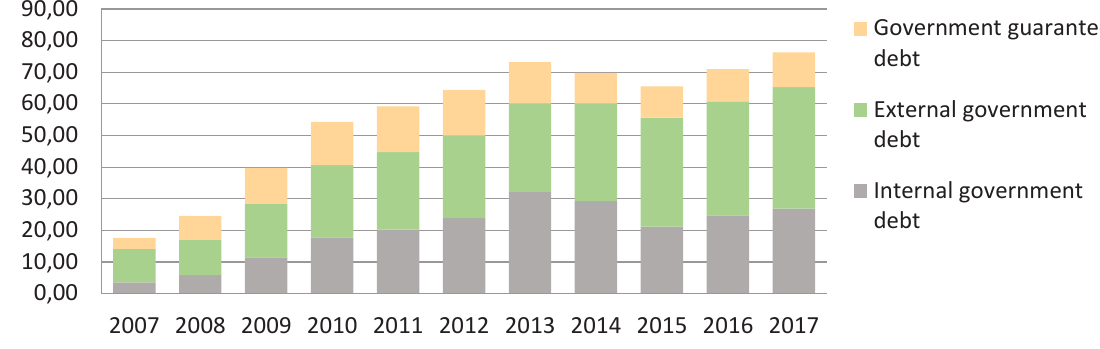
Figure 6. Government debt of Ukraine in the years 2007–2017, USD billion